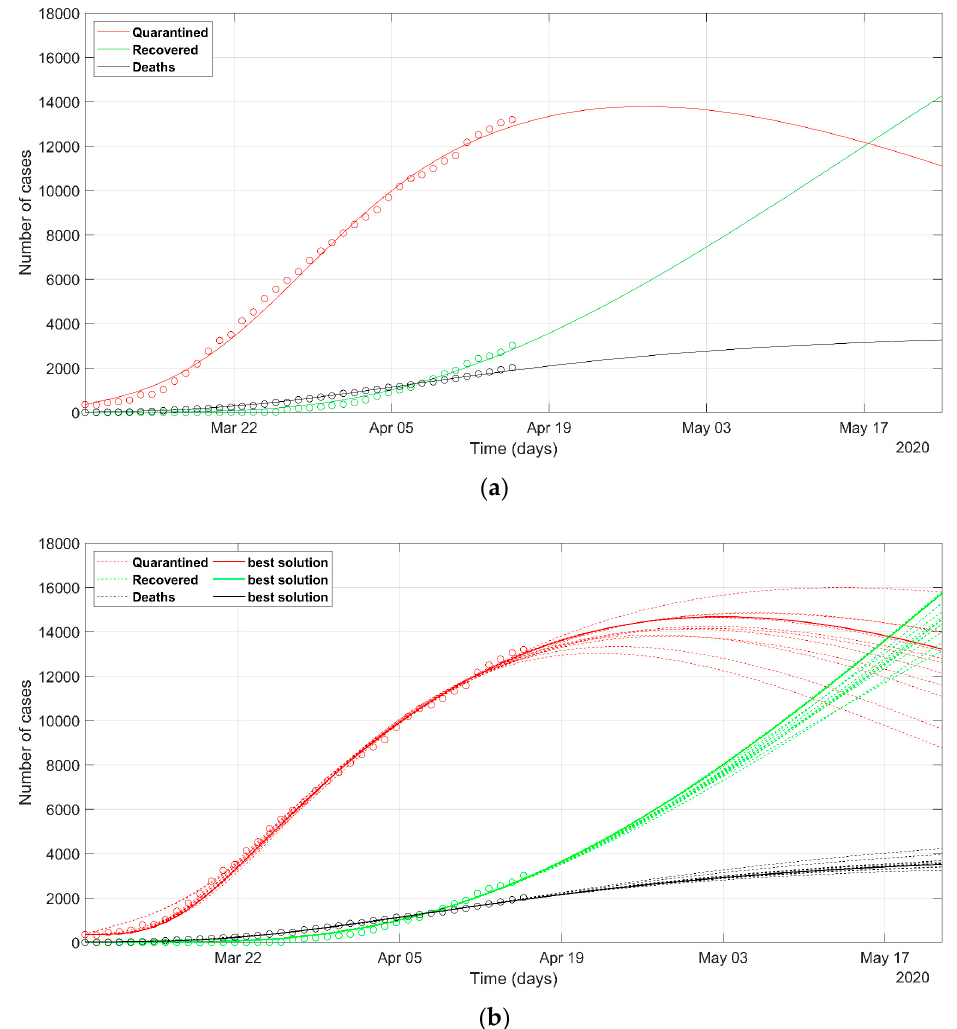
Figure 6. Observed data ( circles ) of quarantined ( red ), recovered ( green ), and deaths ( black ) for the Piedmont region, updated on 15 April 2020. The continuous lines refer to the predicted evolution in 30 days according to the SEIR model solved with ( a ) deterministic approach, ( b ) stochastic approach. In ( b ) the solid line refers to the best PSO solution, the dashed lines refer to the most probable solutions (i.e., the solutions within 5% of the minimum NRMSE).